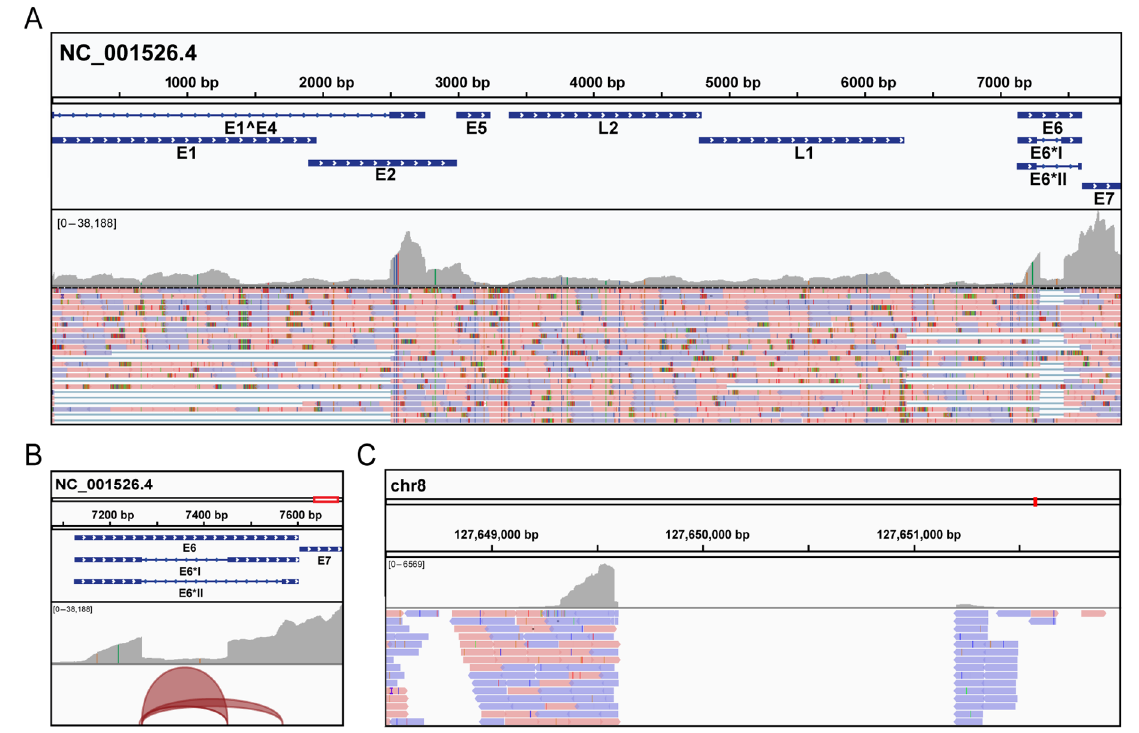
Figure 3. Detection of HPV mRNA in Case 2 by targeted sequencing. Total RNA was first extracted from the Case 2 brain metastasis, followed by separation of the mRNA fraction using oligo dT magnetic beads. This was followed by cDNA library preparation and enrichment of HPV encoded cDNAs using the SureSelect protocols. After Illumina sequencing, reads were aligned to HPV16 reference genome (NC_001526.4) and visualized by IGV software. ( A ) Data revealed a high level of E6 and E7 expression in the tumor. ( B ) The junction track showing alternative splice junctions in the E6 gene. The E6*I splice junction had more coverage (8368 reads) than E6*II (1561 reads). ( C ) Consistent with the DNA sequencing, human reads were detected for the integration site at 8q24.21, indicating the presence of a chimeric mRNA encoded from both HPV16 and the host genome.